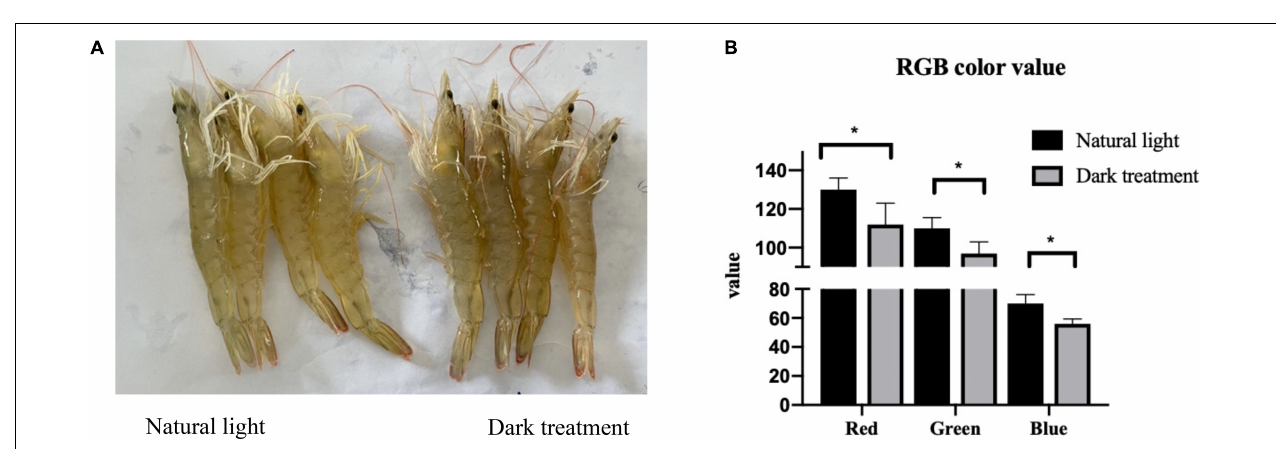
FIGURE 1 | Experimental protocol.